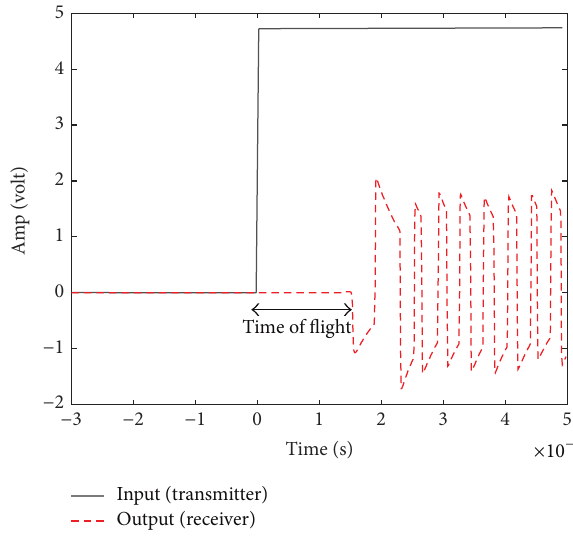
Figure 10: Procedure for determining P-wave time of flight at the A-II point in slab S1.